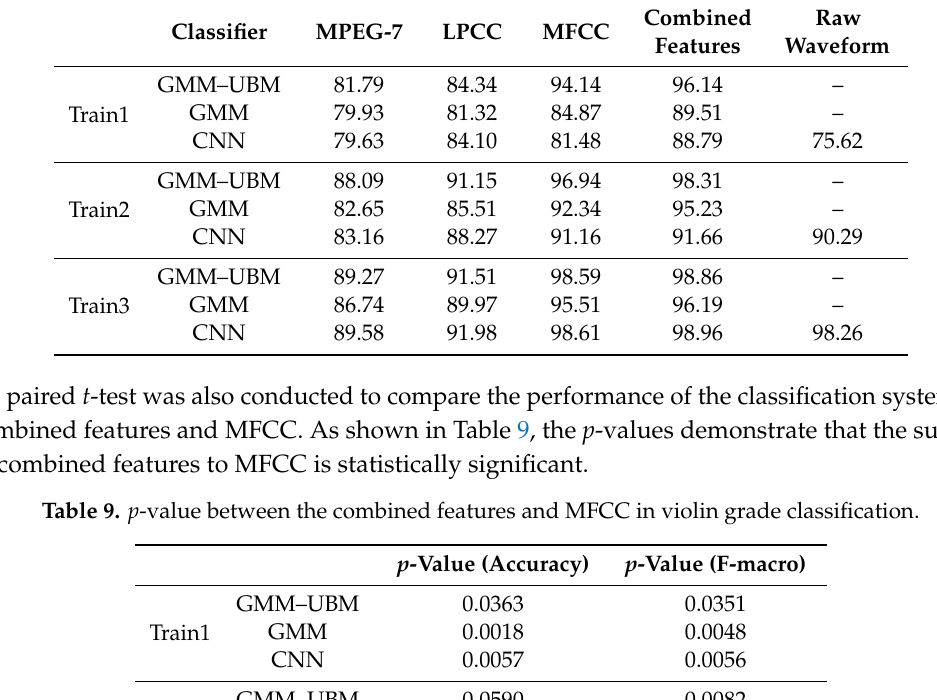
Table 8. Classification accuracy of the medium-grade violins (%).